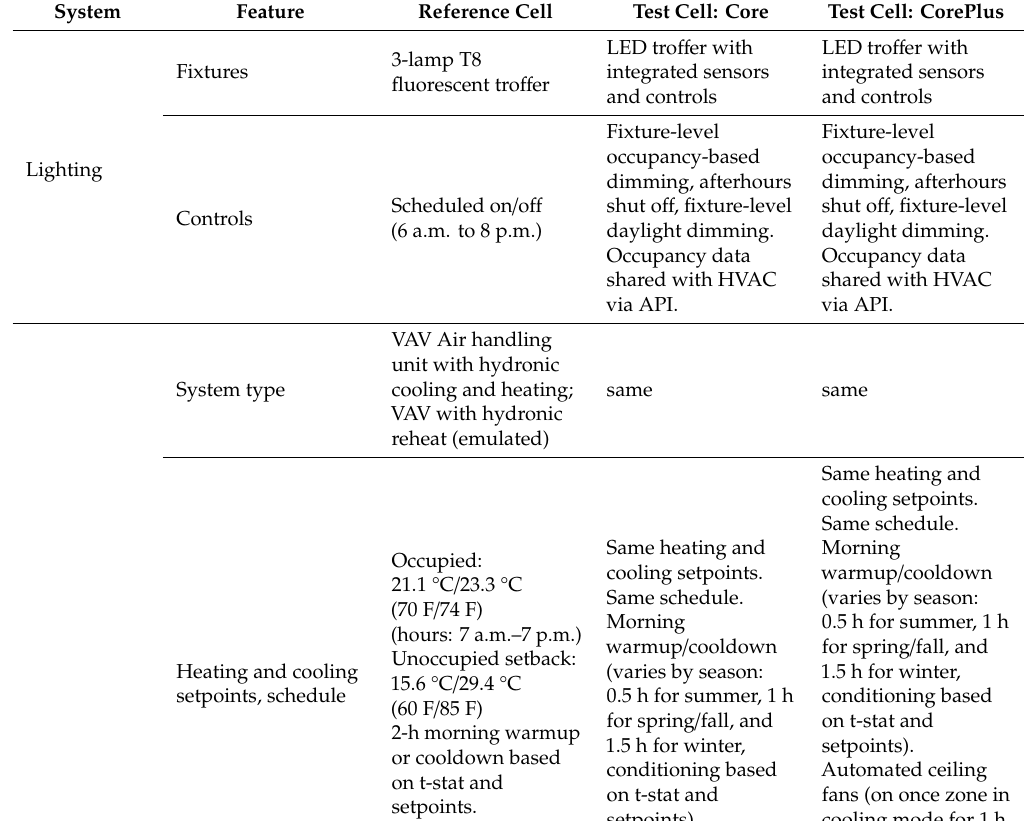
Table 2. System features in reference and test